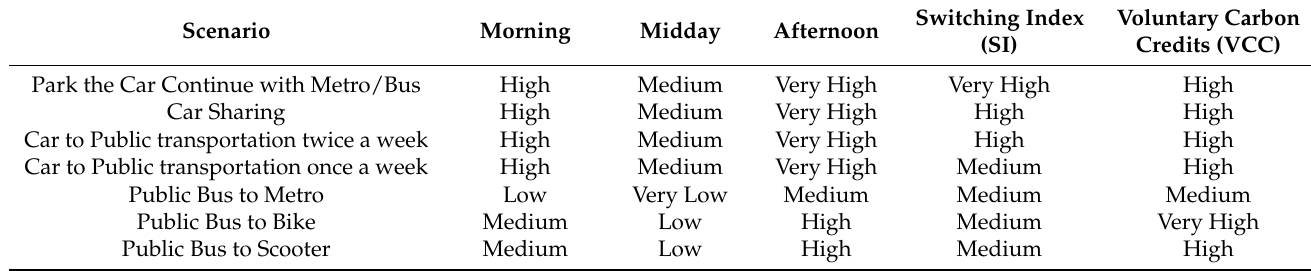
Table 2. Switching scenarios and plans with sample